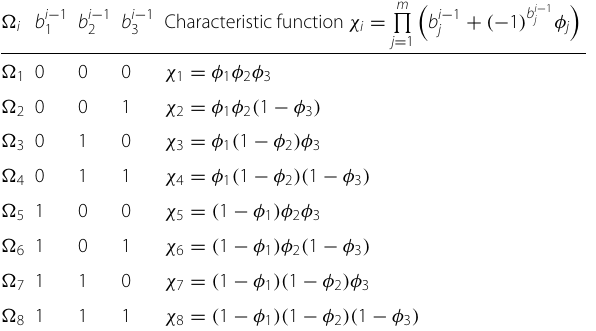
Table 1 Relationship between binary region number and characteristic